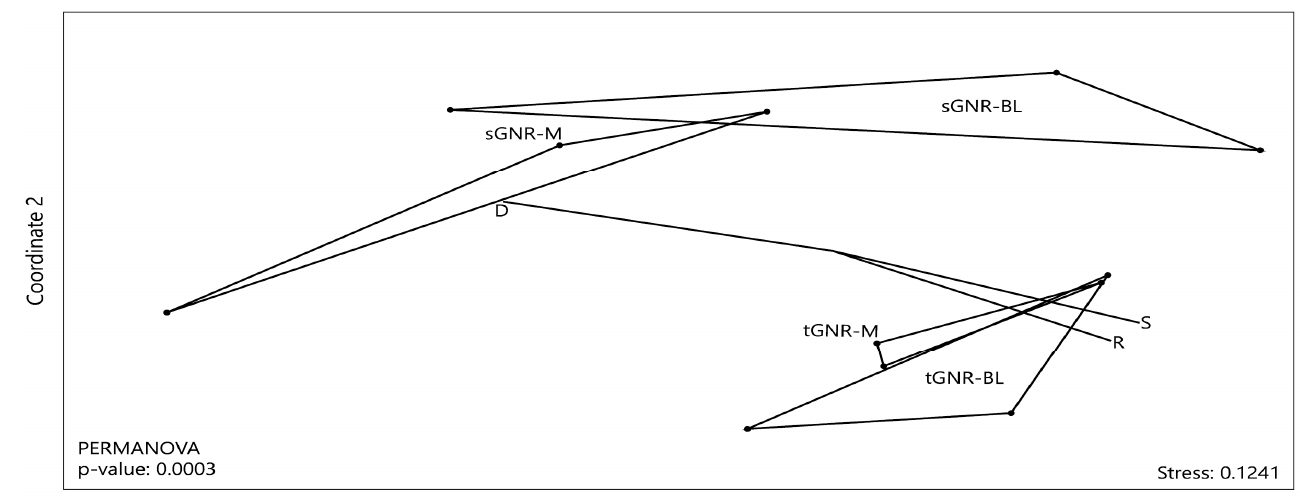
Figure 3. Evolution of the solid phase of long-term enrichment cultures containing synthetic Fe(III) oxyhydroxides as the Fe(III) source. Inocula were obtained from the Gualaxo do Norte River affected (GNR-BL) or not (GNR-M) by tailings from the Fundão Dam. ( a ) Cultures 20 days old. From left to right: GNR-M-A, GNR-M-B, GNR-M-C, GNR-BL-A, GNR-BL-B, and GNR-BL-C. Note the darker color of the second flask (GNR-M-B). ( b ) Control (autoclaved) cultures 20 days old, where the solid phase shows a uniform rust color. ( c ) Solid phase retrieved after 170 days of incubation, showing magnetic min- erals attracted to small, strong magnets. The magnetic interaction energy is sufficient to maintain the magnets suspended on the flask walls. From left to right, the samples are GNR-M-B, GNR-M-C, and GNR-BL-A.